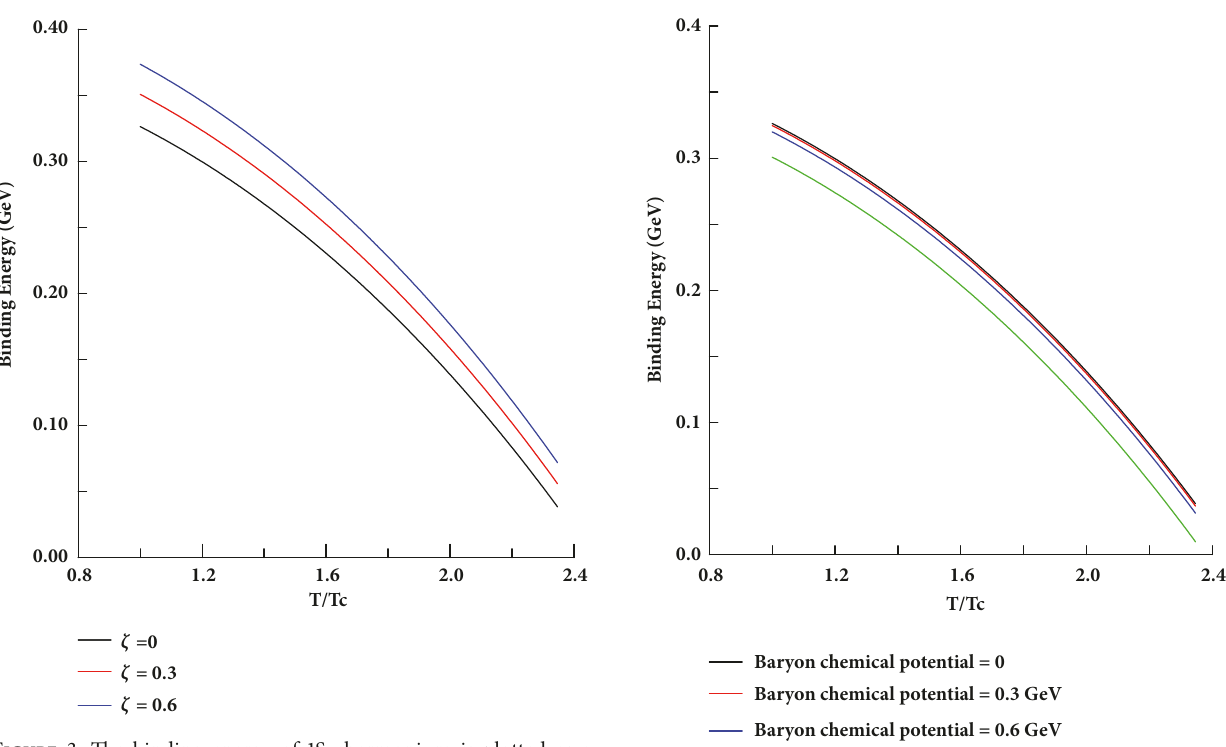
Figure 3: The binding energy of 1S charmonium is plotted as a function of temperature at zero chemical potential and N = 3 for different values of 𝜉 .